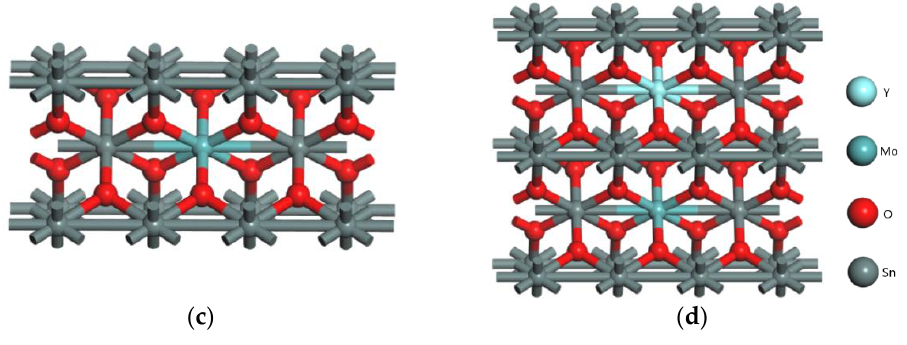
Figure 1. ( a – d ) Models of SnO 2 and SnO 2 doping.